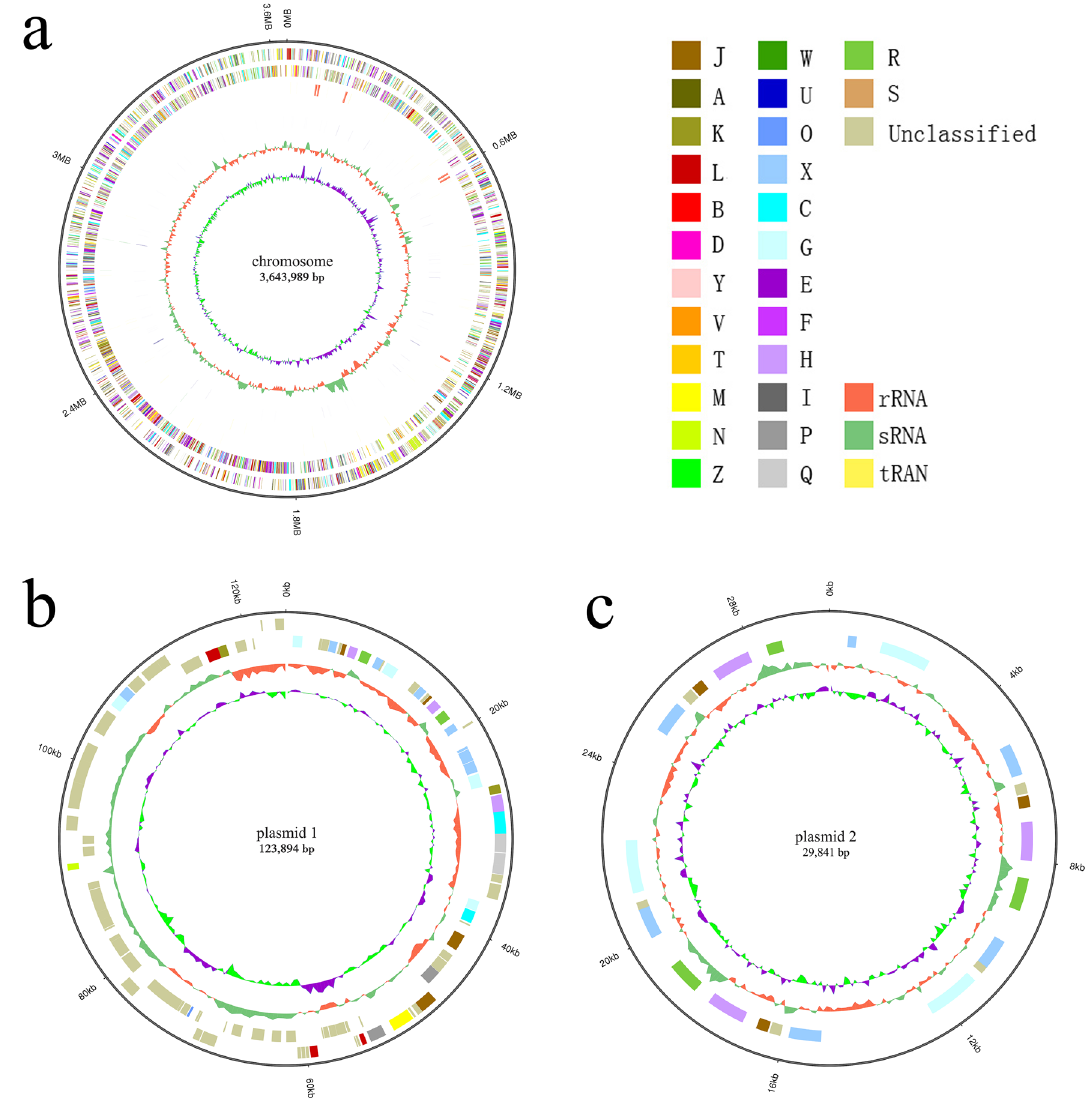
Figure 1. Circular map of the chromosome ( a ), plasmid1 ( b ) and plasmid2 ( c ) of strain OTC-16. From inner to outer: Genome size; Forward Strand Gene(coloured by COG classification); Reverse Strand Gene(coloured by COG classification); Forward Strand ncRNA; Reverse Strand ncRNA; Repeat gene; G + C content; GC-SKEW(calculated as (G-C)/(G + C); green/purple peaks out/inside the circle indicate values higher or lower than 1,